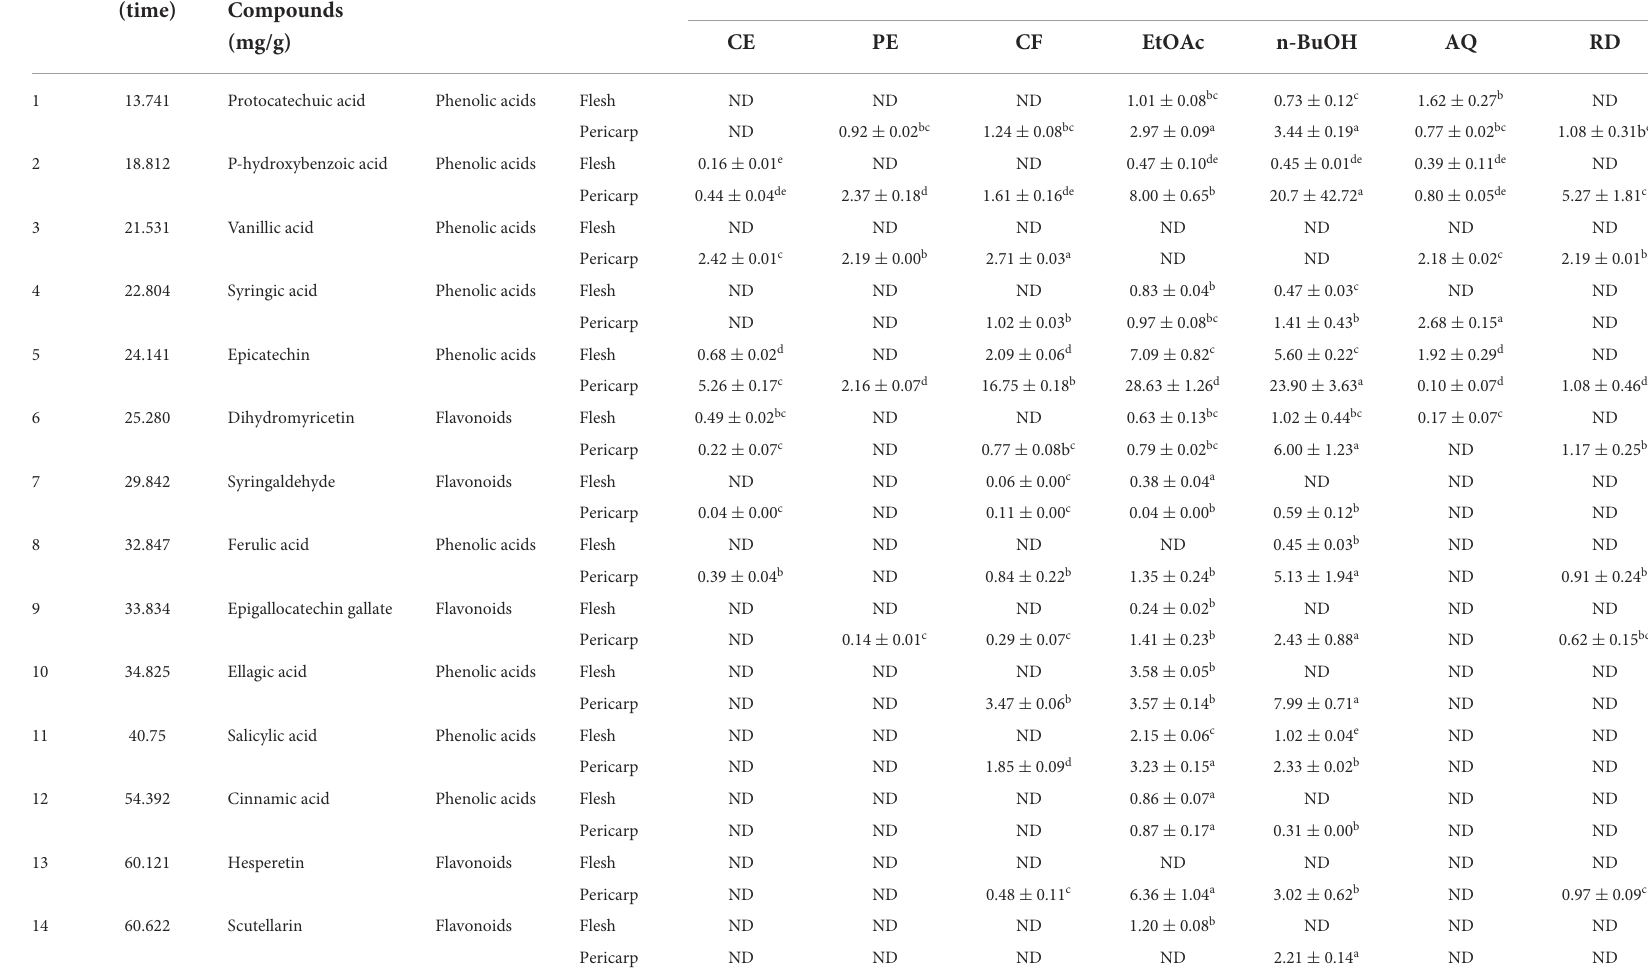
TABLE 3 The content of individual phenolics from SOF and SOP different